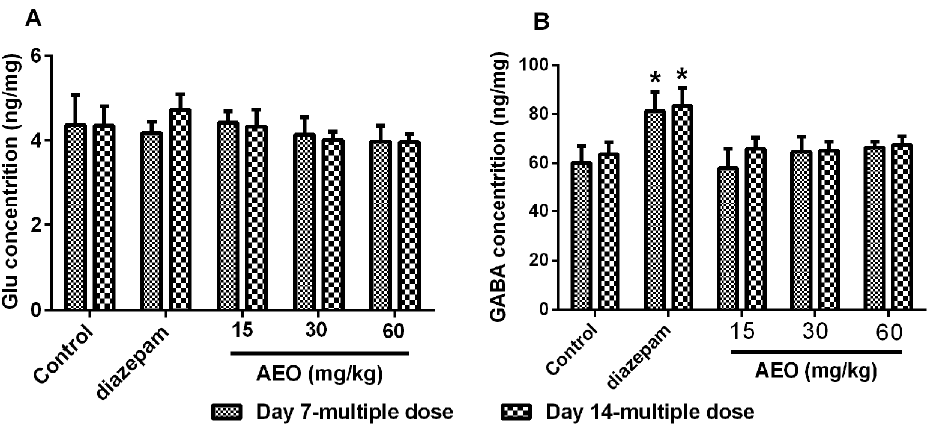
Figure 5. Effect of AEO on brain neurotransmitters in mice. Concentration of ( A ) glutamic acid (Glu) and ( B ) γ -aminobutyric acid.(GABA) were analyzed by ultrafast liquid chromatography-tandem mass spectrometry (UFLC-MS/MS). The cerebral cortex tissues were collected after a locomotor activity test. The results are presented as mean ± SEM with n = 6. * p < 0.05 vs. control group at the same time.